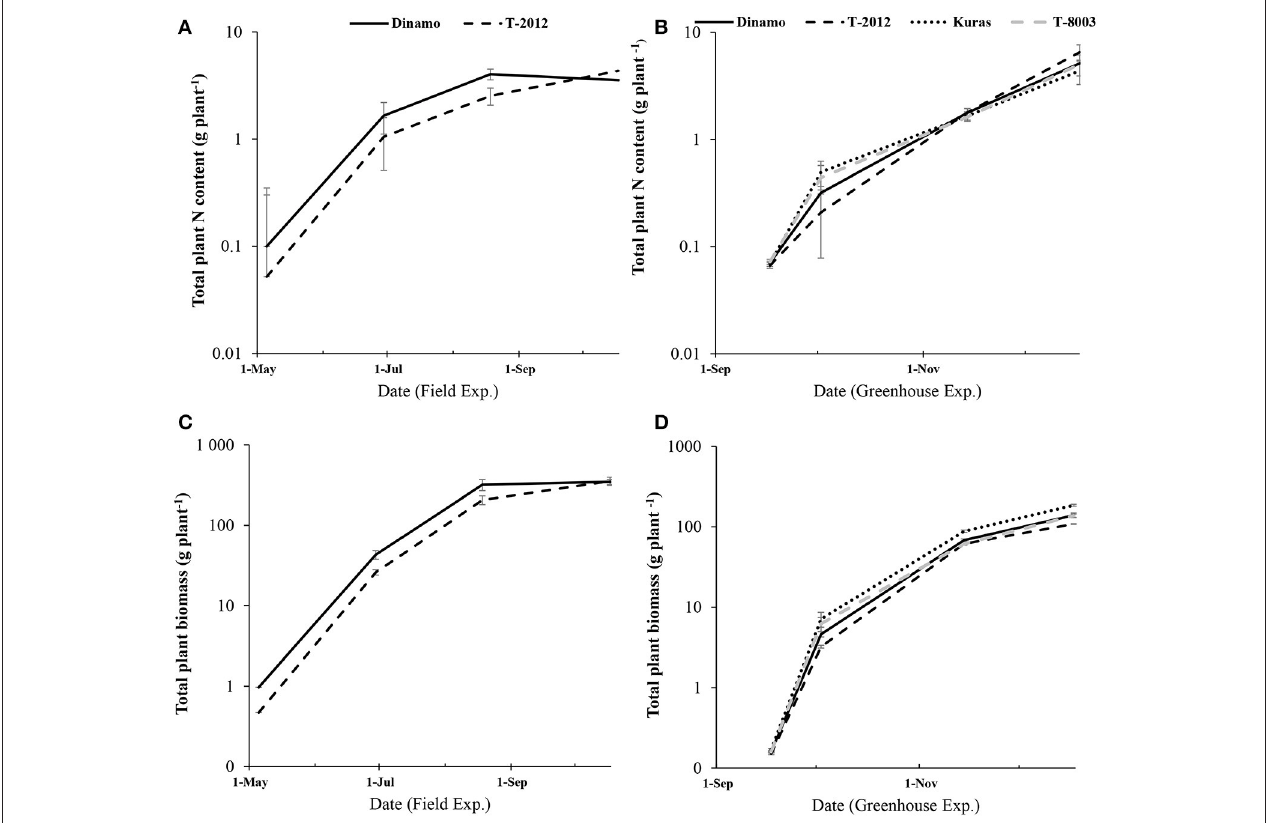
FIGURE 1 | Development of total plant N content and biomass accumulation (in above-ground and tubers) during two experiments from the initial biomass to tuber initiation, flowering stage and final harvest. (A,C) the field study (May to October; 2015) and (B,D) the greenhouse experiment (September- December; 2014). Note the logarithmic scale in the y-axis. The bars are standard errors ( n = 5 and 10 in greenhouse and field, respectively).